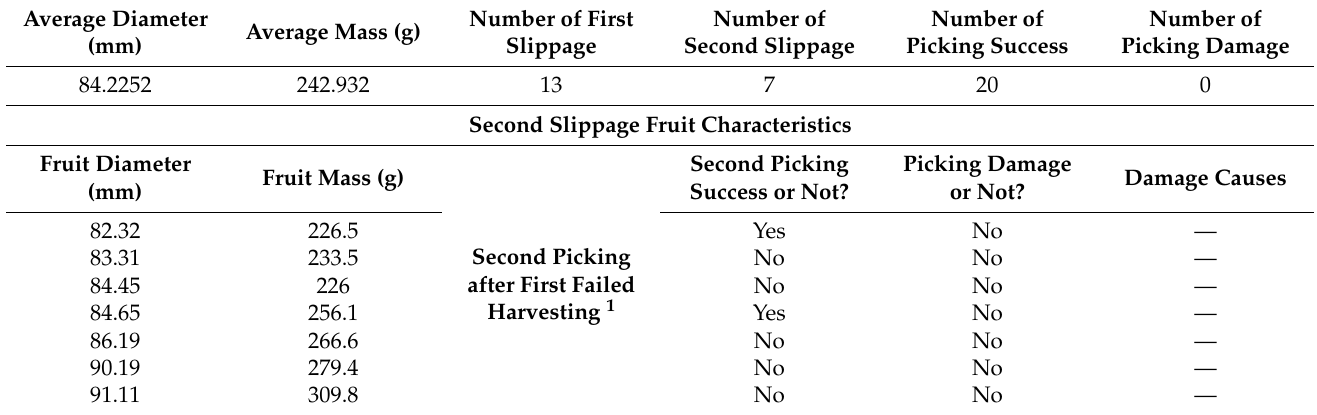
Table 4. The harvesting situation of soft fingers with slip